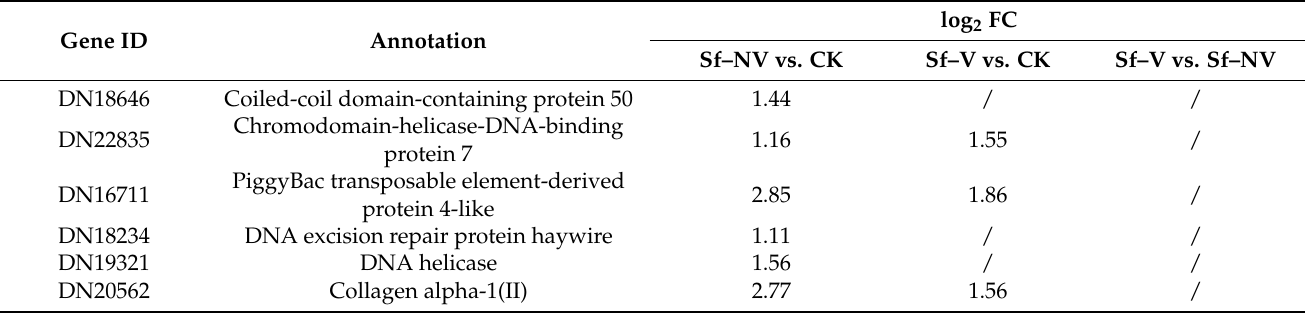
Table 5. Identification of DEGs associated with female-specific genes in S. furcifera females. Gene ID